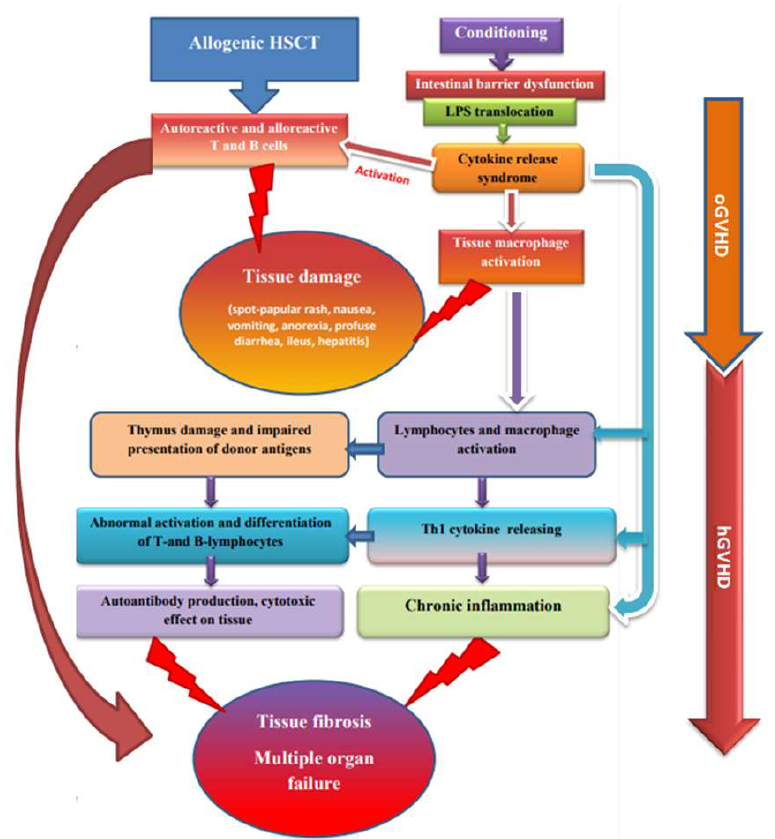
Figure 1. Relationship between aGVHD and cGVHD pathogenesis.